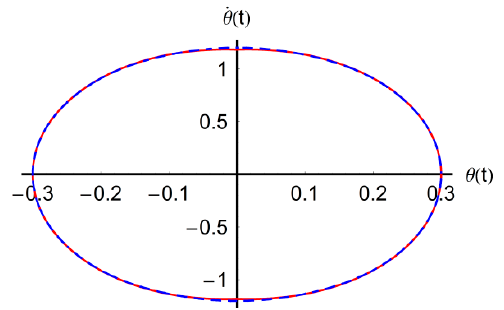
Figure 21. Phase plane for A = 0.4, L = 0.6. Figure 15. Phase plane for A = 0.3, a = 0.2, L = 0.6. _____ numerical_ _ _ _approximate solution (45). Figure 15. Phase plane for A = 0.3, a = 0.2, L = 0.6.